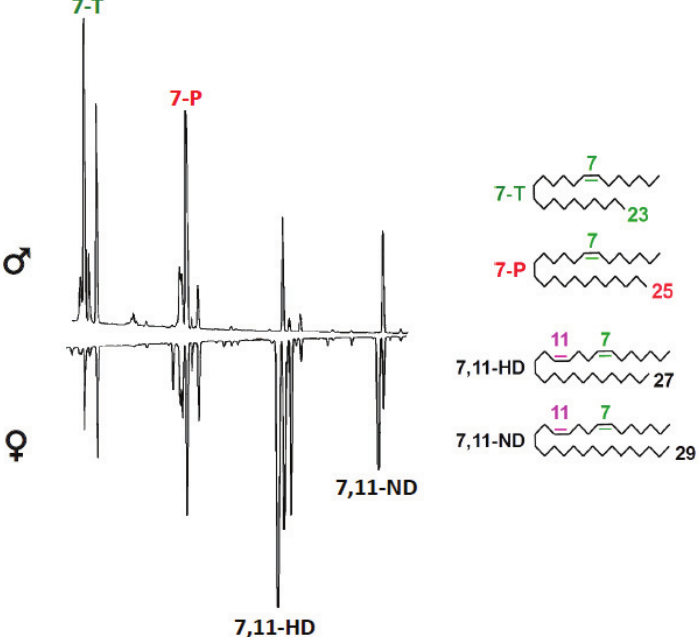
Figure 4. Typical chromatograms of cuticular hydrocarbons from a male and female cosmopolitan D. melanogaster strain (Canton-S). The main pheromones are indicated on the chromatogram on the left and their chemical structures are shown on the